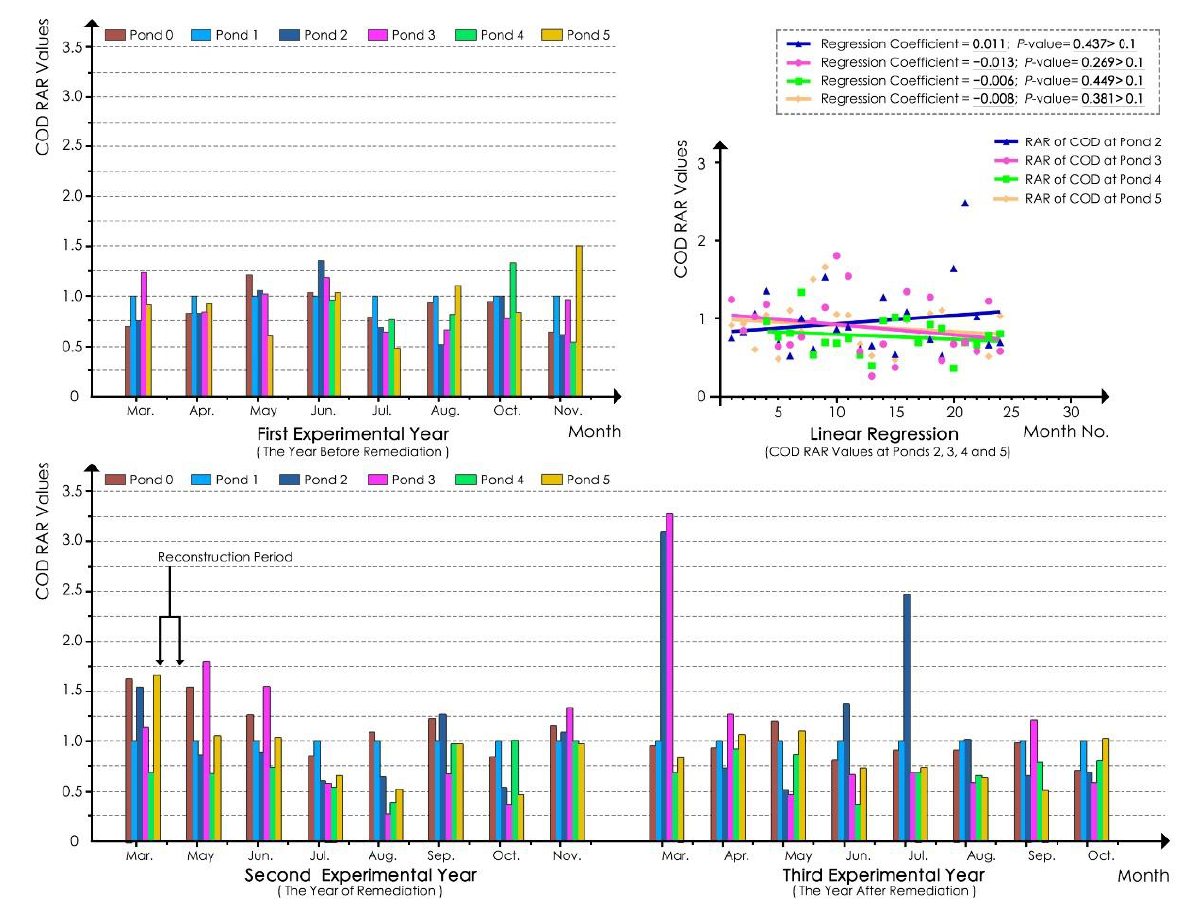
Figure 7. COD RAR values for each pond. Table 9. Statistics of the RAR 1 of the quarterly average COD value at each pond.